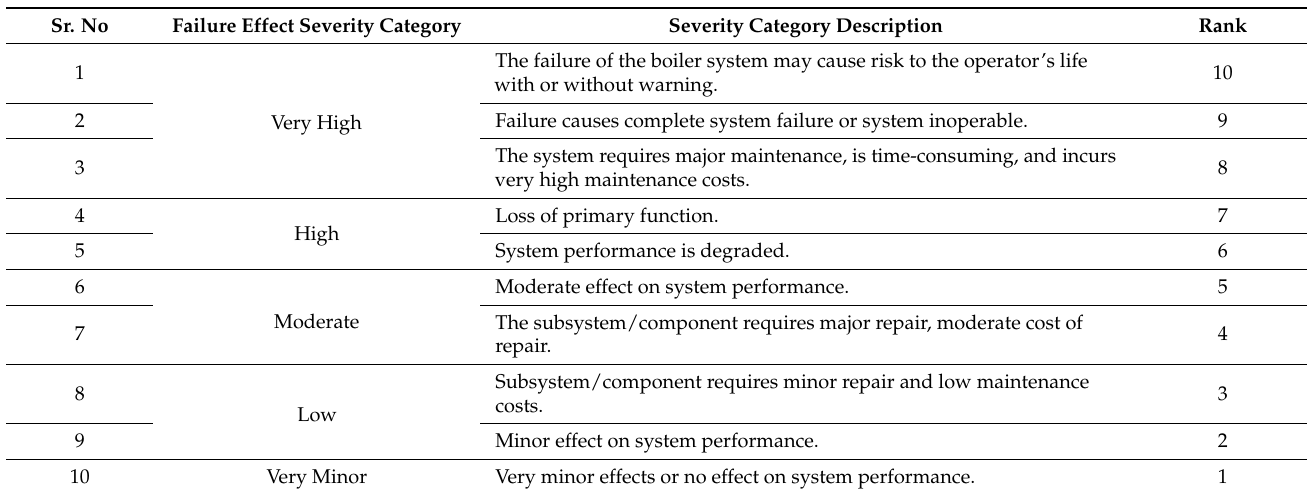
Table 1. FMECA scale to rate severity (SV).